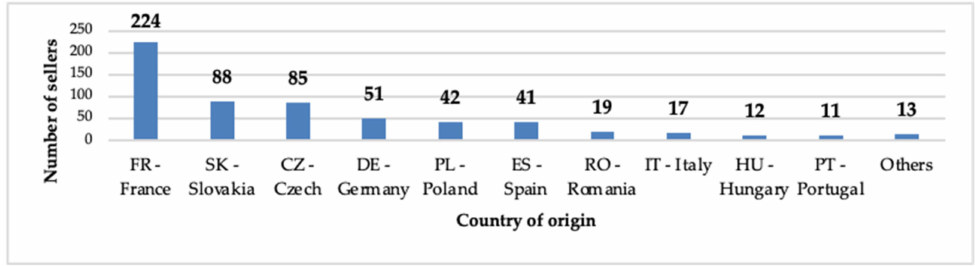
Figure 5. Supply chain for Citroen C3 and Peugeot 208 (2019). Source: Authors’ compilation. The outcomes of implementing the PSA TT (Trnava) supply chain in its entirety across Europe for the C3 and 208 models were displayed in 2019. There are 224 French companies (37.15%) and 85 Czech companies (14.1%). With 88 sellers, Slovak merchants are in the lead. Slovakia was PSA Group SVK TT’s second-largest supplier of parts and components for automobiles (the C3 and 208) in 2019 (14.6%). There are now 603 sellers overall